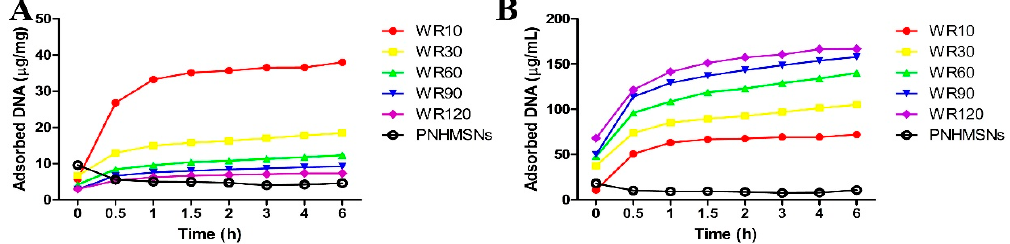
Figure 3. The DNA adsorption by PEI-HMSNs. ( A ): DNA adsorption isotherms by PEI-HMSNs with various PEI-HMSNs/DNA weight ratios and PNHMSNs/DNA at WR60; ( B ): Total DNA ( µ g/mL) in the sediment after incubating DNA with PEI-HMSNs and PHMSNs/DNA at WR60 was calculated by subtracting DNA in the supernatant determined at different time intervals from initial total DNA added.